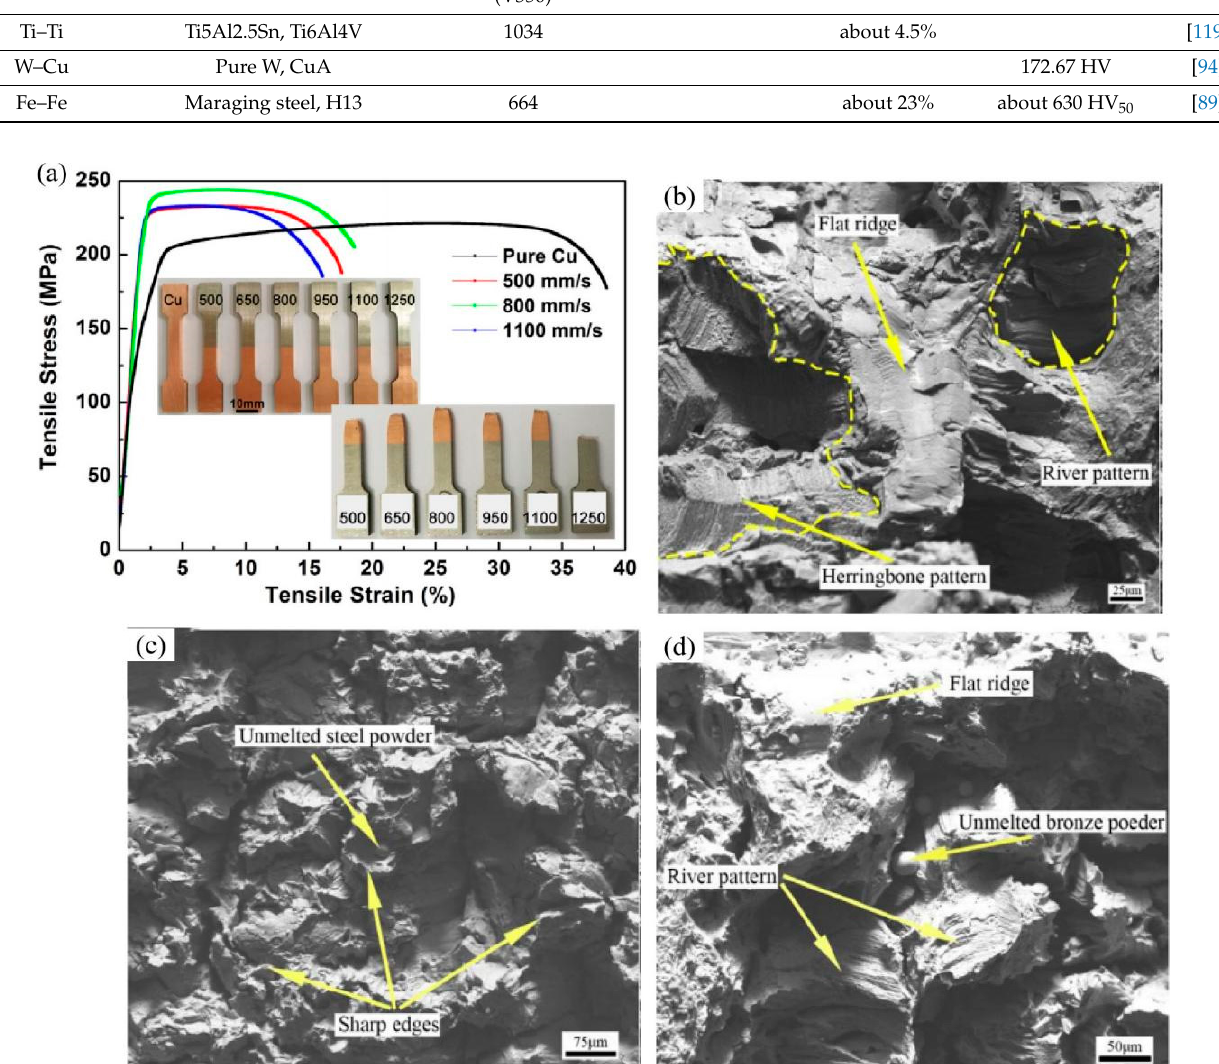
Figure 10. ( a ) Tensile stress–strain curves produced by different processing parameters; ( b ) The fusion-zone fracture morphology of horizontal combination; ( c , d ) CuSn10 side and 316L side fracture morphologies [103,104].